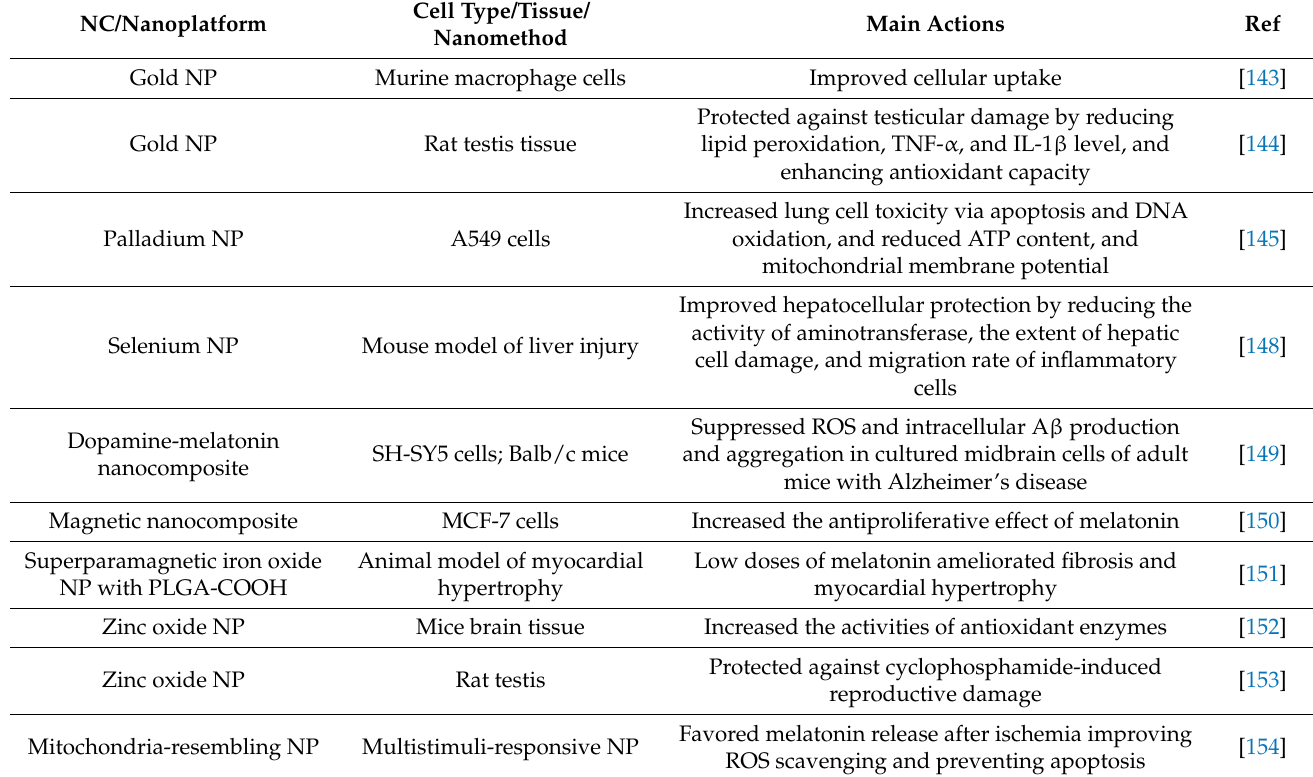
Table 2. Melatonin incorporated into metallic NPs and related metallic and non-metallic nanocomposites improved biological and biochemical-like processes in different animal models and cell types.